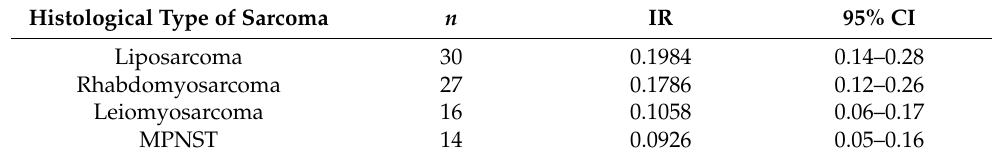
Figure 3. Trend of soft tissue sarcoma incidence rate with age. Age specific incidence rates increased substantially with increasing age. Table 1. Incidence rates (IR) for the four most common histological types of soft tissue sarcoma. Histological Type of